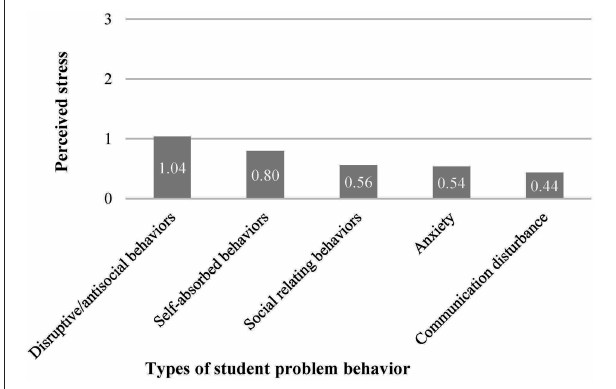
FIGURE 2 | Subscale means of perceived stress due to different student problem behavior domains in ranked order (0, not stressful; 1, a little stressful; 2, stressful; 3, very